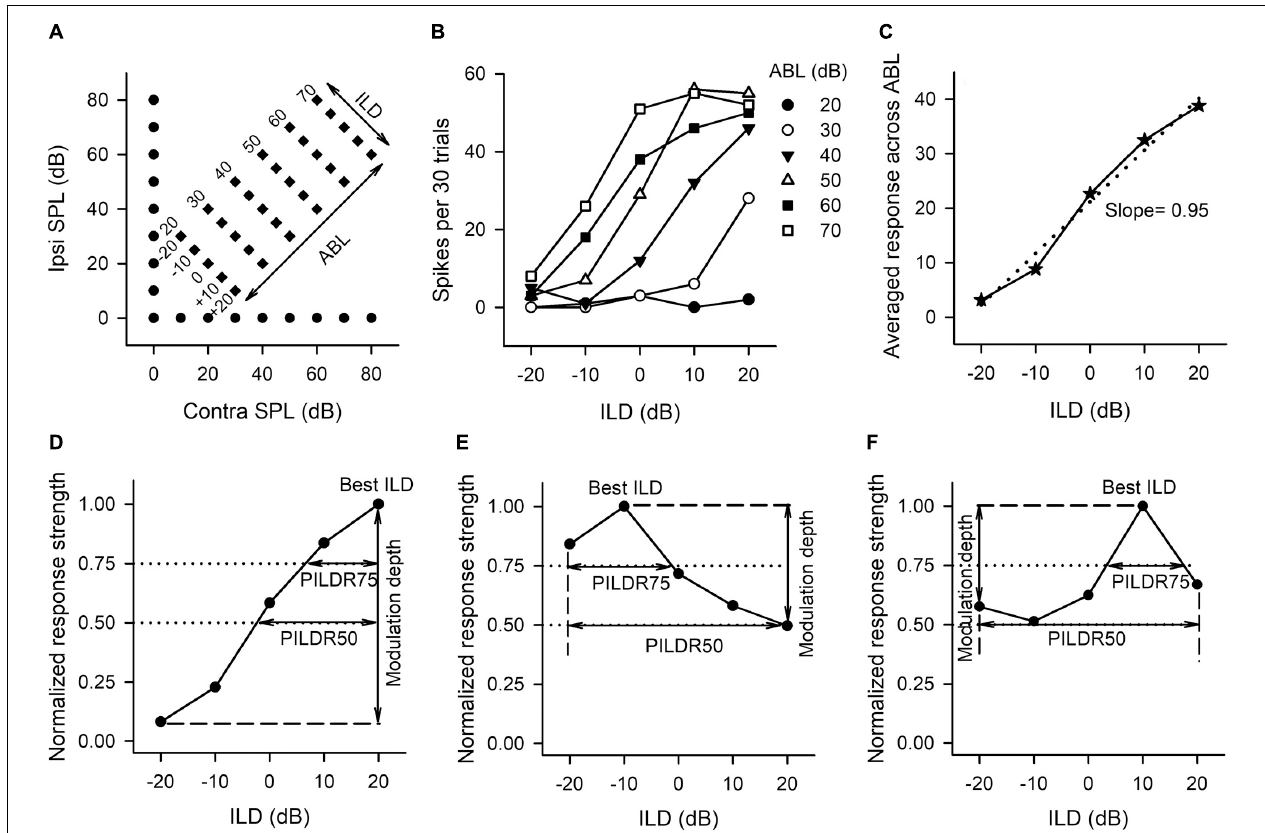
FIGURE 1 | The sound stimulus paradigm and the method to determine the neuronal sensitivity and selectivity to ILDs from the ILD response functions of AI neurons. (A) The sound stimulus paradigm. The monaural stimuli (filled circles) and the binaural stimuli (filled diamonds) are designated in terms of contralateral (contra) and ipsilateral (ipsi) sound pressure levels in dB (dB SPL). The binaural stimulus can also be shown in terms of interaural level difference (ILD) and average binaural level (ABL). Positive ILDs favor the contralateral ear and negative ILDs favor the ipsilateral ear. (B) The ILD response functions of an AI neuron determined at different ABLs. (C) The averaged ILD response function across ABLs from the data in panel (B) (solid line) and the linear curve fitting function (dotted line). The slope value of this linear function was used as a measure of neuronal sensitivity to ILDs. (D–F) The method to determine the modulation depth, the preferred ILD range (PILDR75, PILDR50), and the best ILDs from the normalized ILD response functions. See texts in section “MATERIALS AND METHODS” for details.